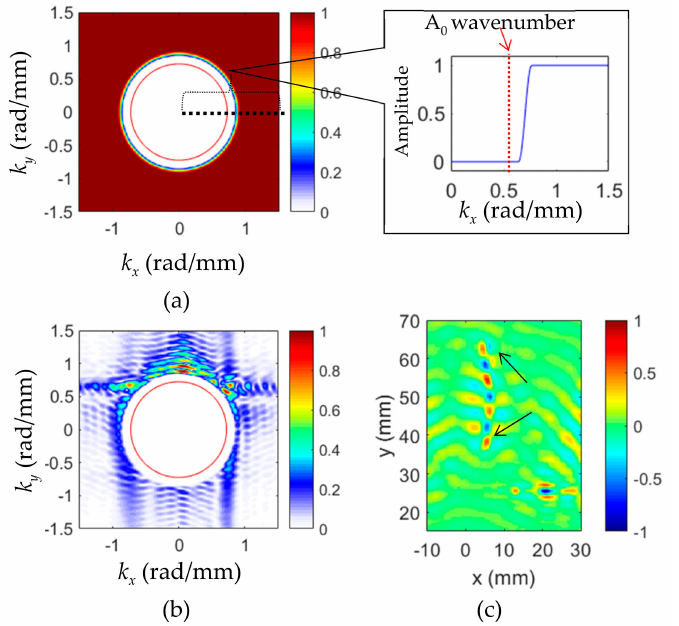
Figure 5. Wavenumber filtering process for the extraction of scattered waves in all directions. ( a ) Designed high-pass filter at 120 kHz for scattered wave filtering; ( b ) filtered scattered wave spectrum; and ( c ) extrapolated scattered wavefield by inverse 3DFT